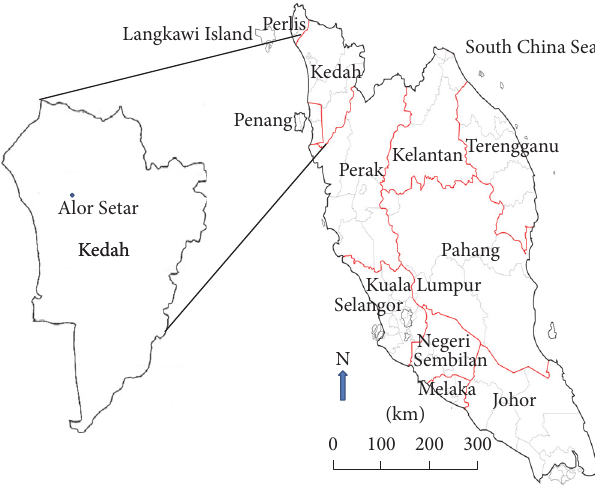
Figure 1: Map of the area